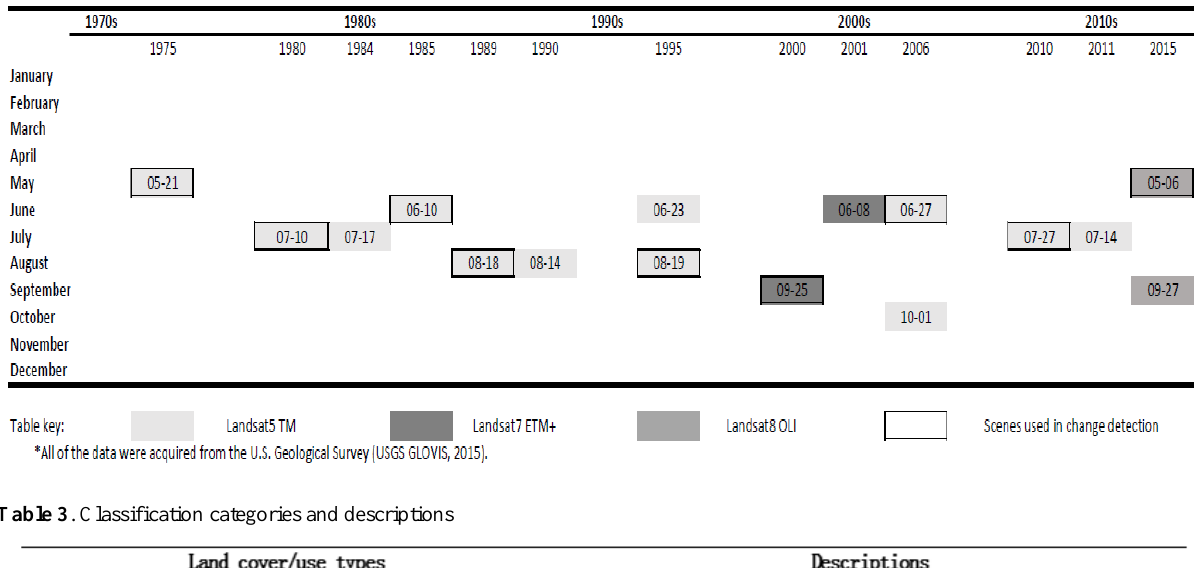
Table 2 . Satellite imagery with 5-year intervals used in this study